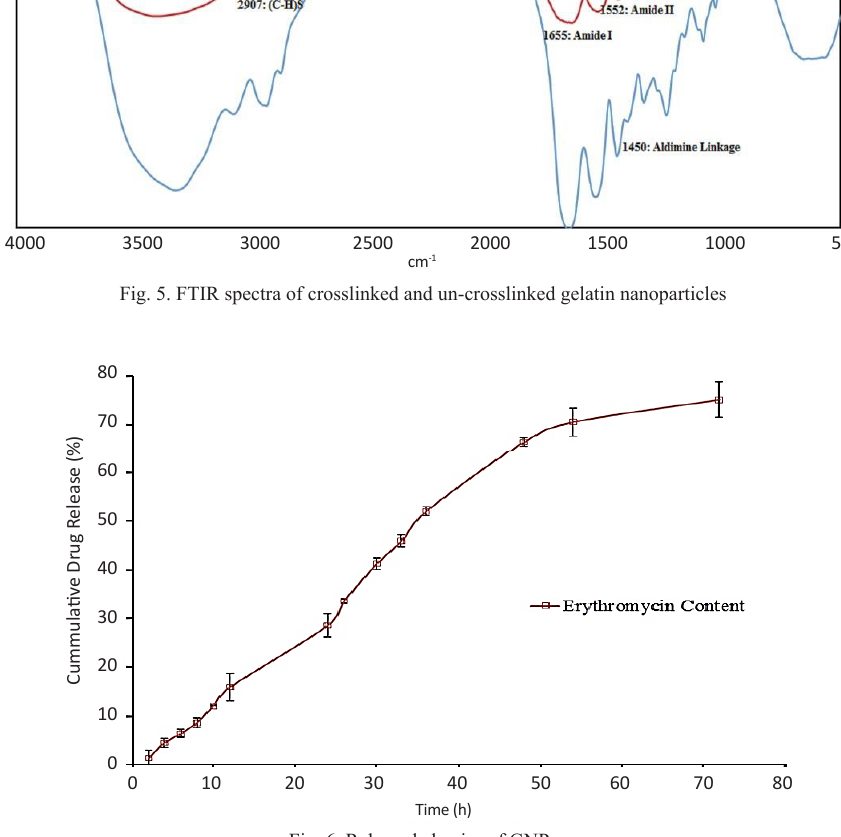
Fig. 6. Release behavior of